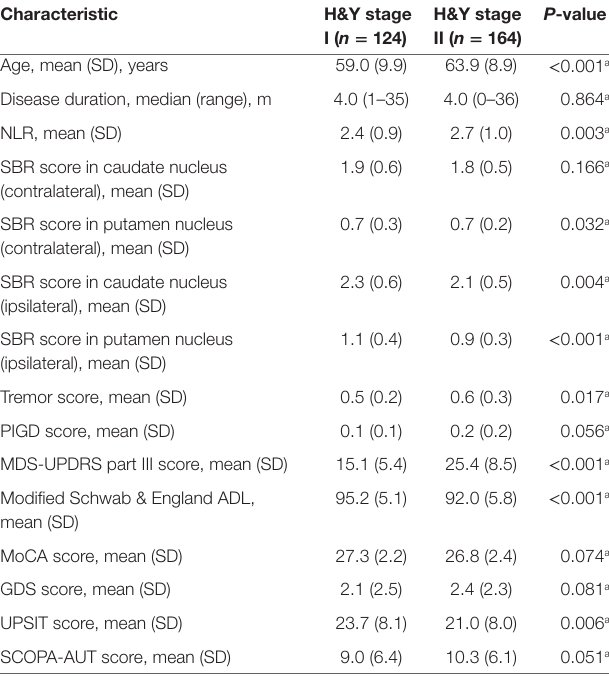
TaBle 4 | Demographic information and comparison of clinical outcomes in patients with Parkinson’s disease (PD) based on H&Y